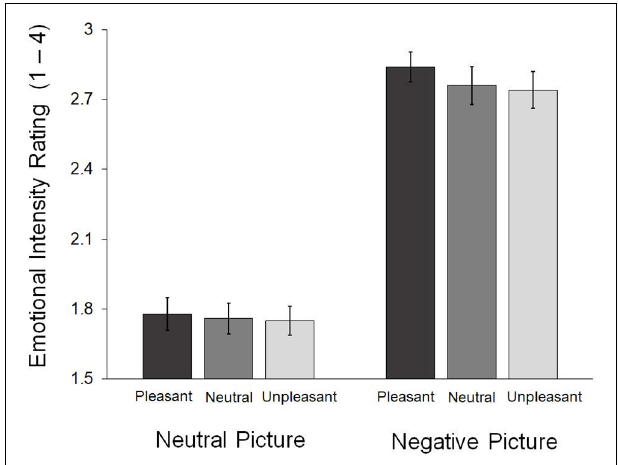
FIGURE 2 | Emotional intensity ratings obtained during the in-scanner task. The error bars indicate the standard errors of the means.